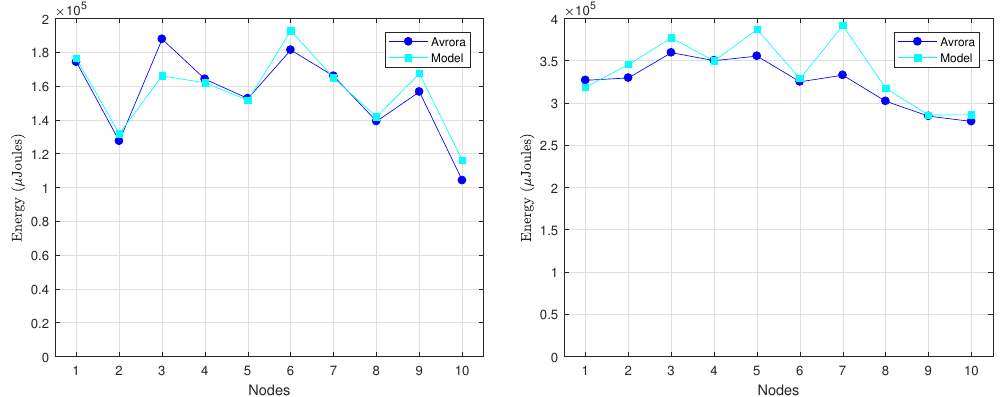
Figure 11. Avrora vs. energy model comparison for the 10-nodes network with DC = 3% ( on the left ) and DC = 10% ( on the right ).